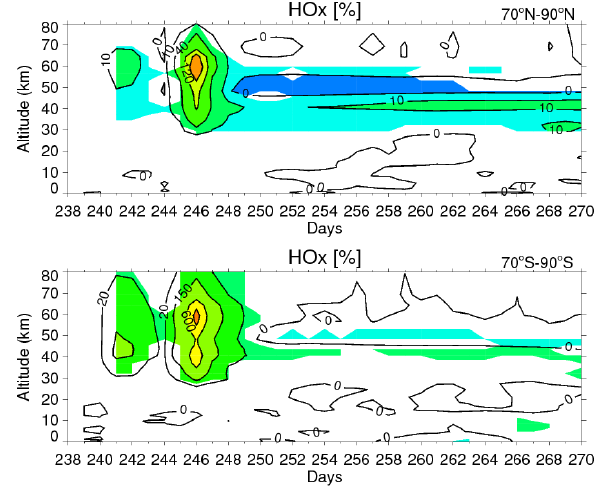
438 Fig. 3: Upper panel : Evolution of changes in HO x zonal mean mixing ratio profile in the polar region 439 (70°-90°N) in percent. Lower panel : same for 70°-90°S. Colors indicate areas with at least 95 % sta- 440 Fig. 3. Upper panel: evolution of changes in HO x zonal mean mix- tistical significance. Contour levels for upper panel: -20, 0, 10, 40, 120, 300 %. Contour levels for 441 ing ratio profile in the polar region (70–90 ◦ N) in percent. Lower lower panel: -20, 0, 20, 150, 600, 1000 %. 442 panel: same for 70–90 ◦ S. Colors indicate areas with at least 95% 443 statistical significance. Contour levels for upper panel: − 20, 0, 50, 150, 300%. Contour levels for lower panel: − 20, 0, 50, 250, 700,